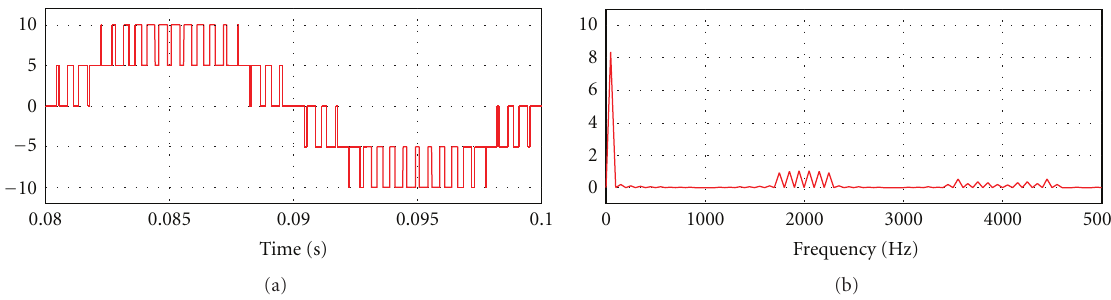
Figure 11: PWM output current waveform i inv and harmonic content of the proposed circuit with phase-shifted modulation operating at m f I = I = m = 50Hz, and f pv wind , pv wind , line